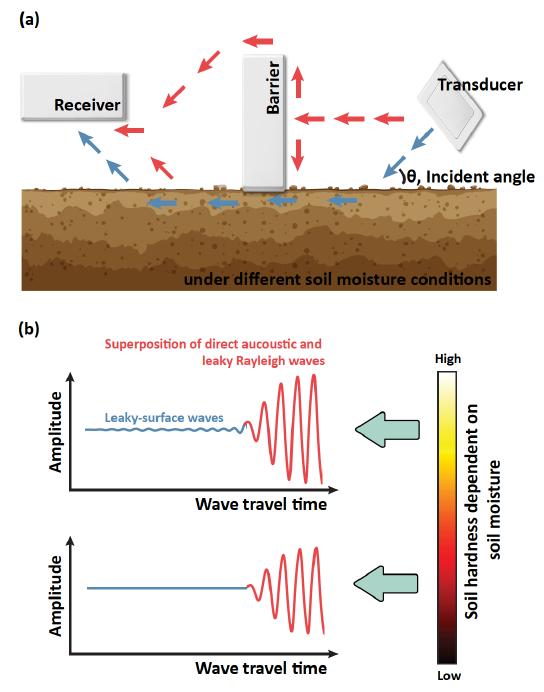
Figure 2. Schematic illustration of air-coupled ultrasonic method. ( a ) Propagation of leaky Rayleigh wave (blue) and direct acoustic (red). ( b ) Measurement scenario of leaky Rayleigh wave depending on soil